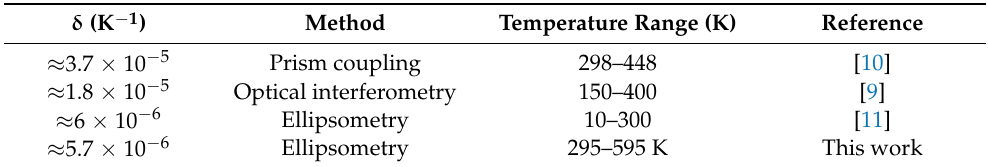
Table 3. Thermo-optic coefficient in β -Ga 2 O 3 as calculated from results obtained in different works by several experimental